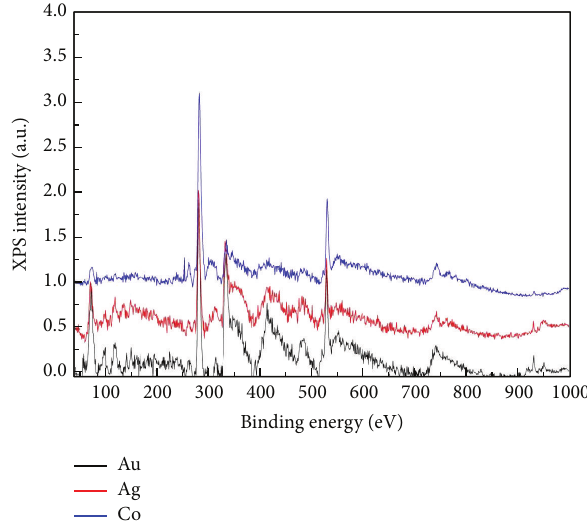
Figure 3: XPS spectra for nanoparticle/HOPG composites. Table 1: Element’s amount on sample surface and XPS main line position evaluated from XPS